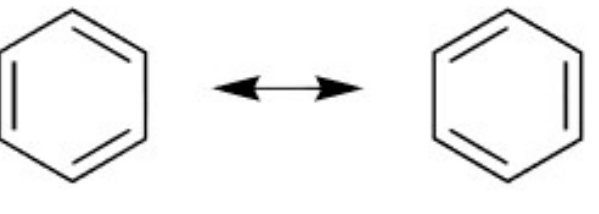
11 of 18 Figure 7. Cell recognition ability comparison. 3.3. Final Elaboration and Implications Based on the assumption that the correct definition of the urbanized environment boundaries passes through the best BSS/TSS values of the grid shifts for the best clustering method, the resonance concept here is used to fit the purpose. Indeed, although five-UA-class K—Means method shows higher BSS/TSS ratio val- ues, none of the single grid translations can return 100% of the urbanized axis. The shifts can hence be considered as resonance structures. The principle already consolidated in the scientific literature can help the conceptualization of a similar ap- proach in territorial sciences. Every single shift represents a resonance structure, namely